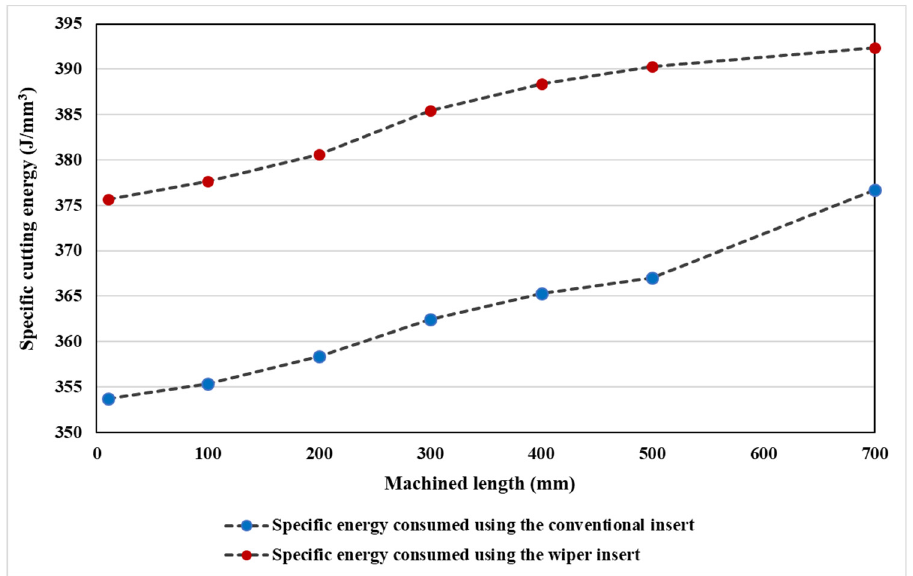
Figure 10. Comparison of the specific energy consumption for the conventional and wiper inserts for various machined lengths.